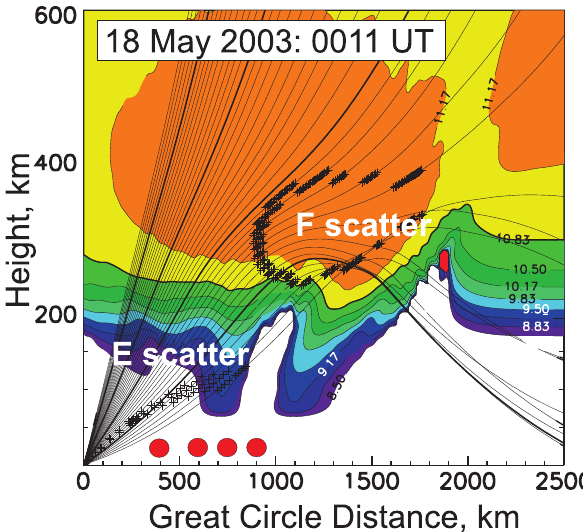
Fig. 3. Electron density distribution along the scintillation re- ceivers meridian and the 2-D ray tracing for the Hankasalmi beam 5 and the event of 18 May 2003, 00:11 UT. Red disks indicate approximate locations of the scintillation re- ceivers. The color coding for the density contours is as fol- lows: blue – between 3 . 16 × 10 8 m − 3 and 6 . 76 × 10 9 m − 3 ; green – between 6 . 76 × 10 10 m − 3 and 6 . 76 × 10 9 m − 3 ; yellow – be- tween 6 . 76 × 10 10 m − 3 and 1 . 48 × 10 11 m − 3 ; brown – above 1 . 48 × 10 11 m − 3 . Rays are shown in 1 ◦ step of elevation angle starting from 5 ◦ . The thicker traces correspond to elevation angles of 10 ◦ , 20 ◦ , 30 ◦ and 40 ◦ .